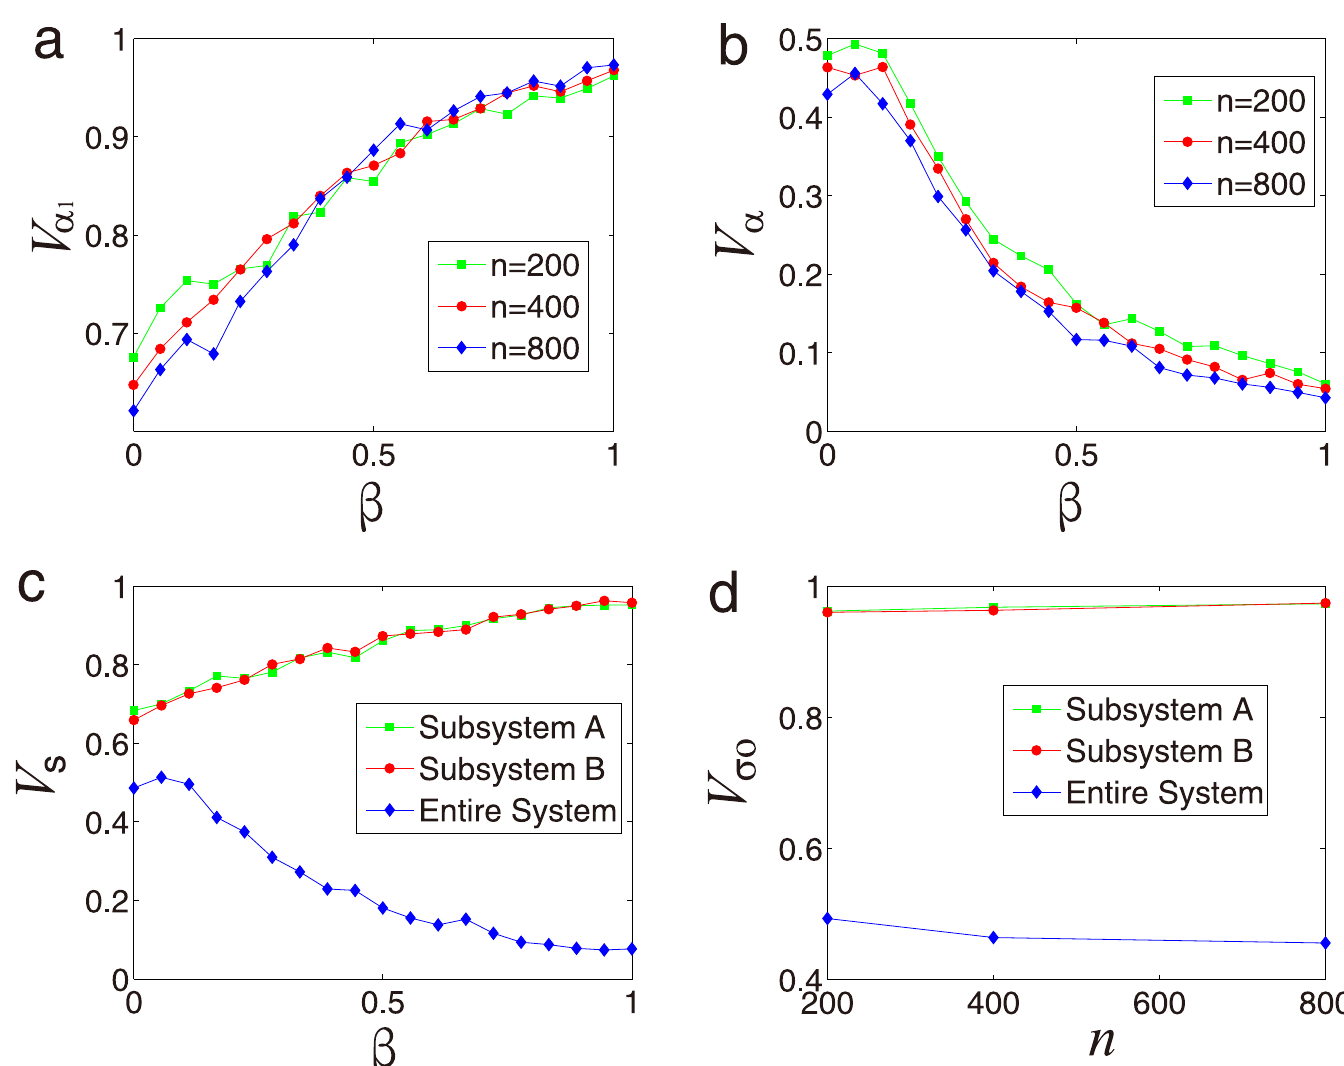
Fig 8. System size and absolute velocity effect for competition relationship. (a) Synchronization V α 1 as a function of the coupling strength β for each subsystem. (b) Synchronization V α as a function of the coupling strength β for the entire system. (c) Synchronization V s as a function of the coupling strength β for each subsystem and the entire system. (d) Optimal synchronization V so as a function of system size n for each subsystem and the entire system. The simulation results are saved in S7 and S8